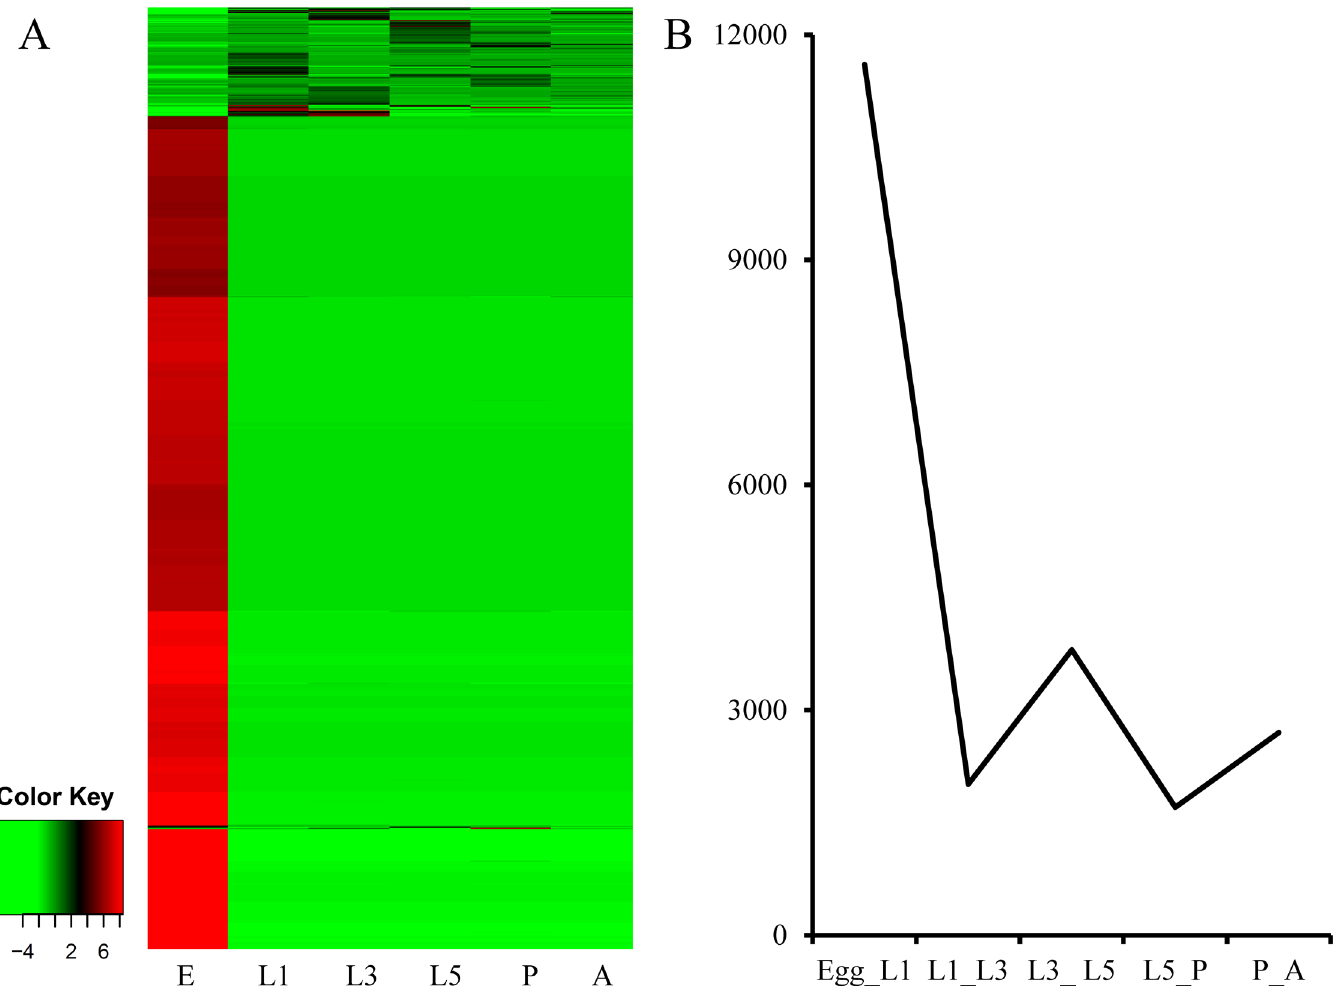
Fig 5. A heat map of genes expression and numbers of genes that significantly change in the Pieris rapae transcriptome druing development. E, L1, L3, L5, L, P, and A refer to the egg, the first stage of larva, the third stage of larva, the fifth stage of larva, the pupa, and the adult of P . rapae , respectively. (A) A heat map for the average transformed numbers of RPKM values of genes in the P . rapae transcriptome. (B) Numbers of genes with 2-fold changed in adjacent stages during